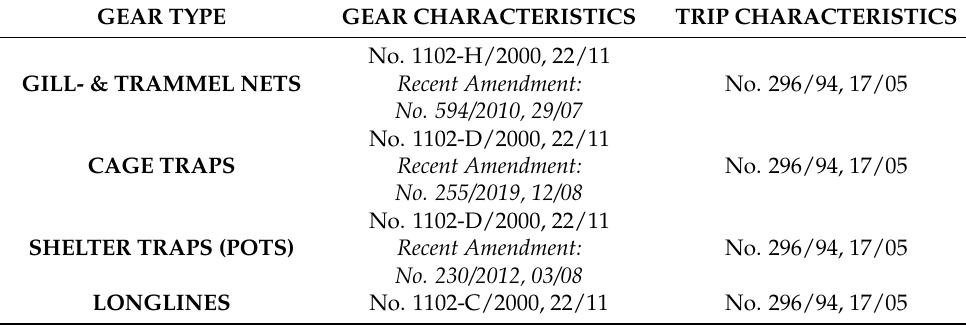
Table A1. The original ordinances used to describe gear and trip characteristics including the most recent amended ordinance (where applicable) per gear type.